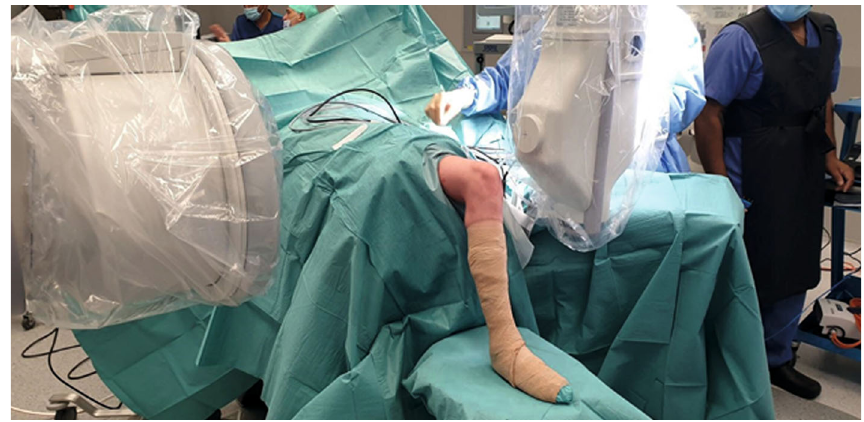
Figure 3: Preoperative position, draping, and preparing.